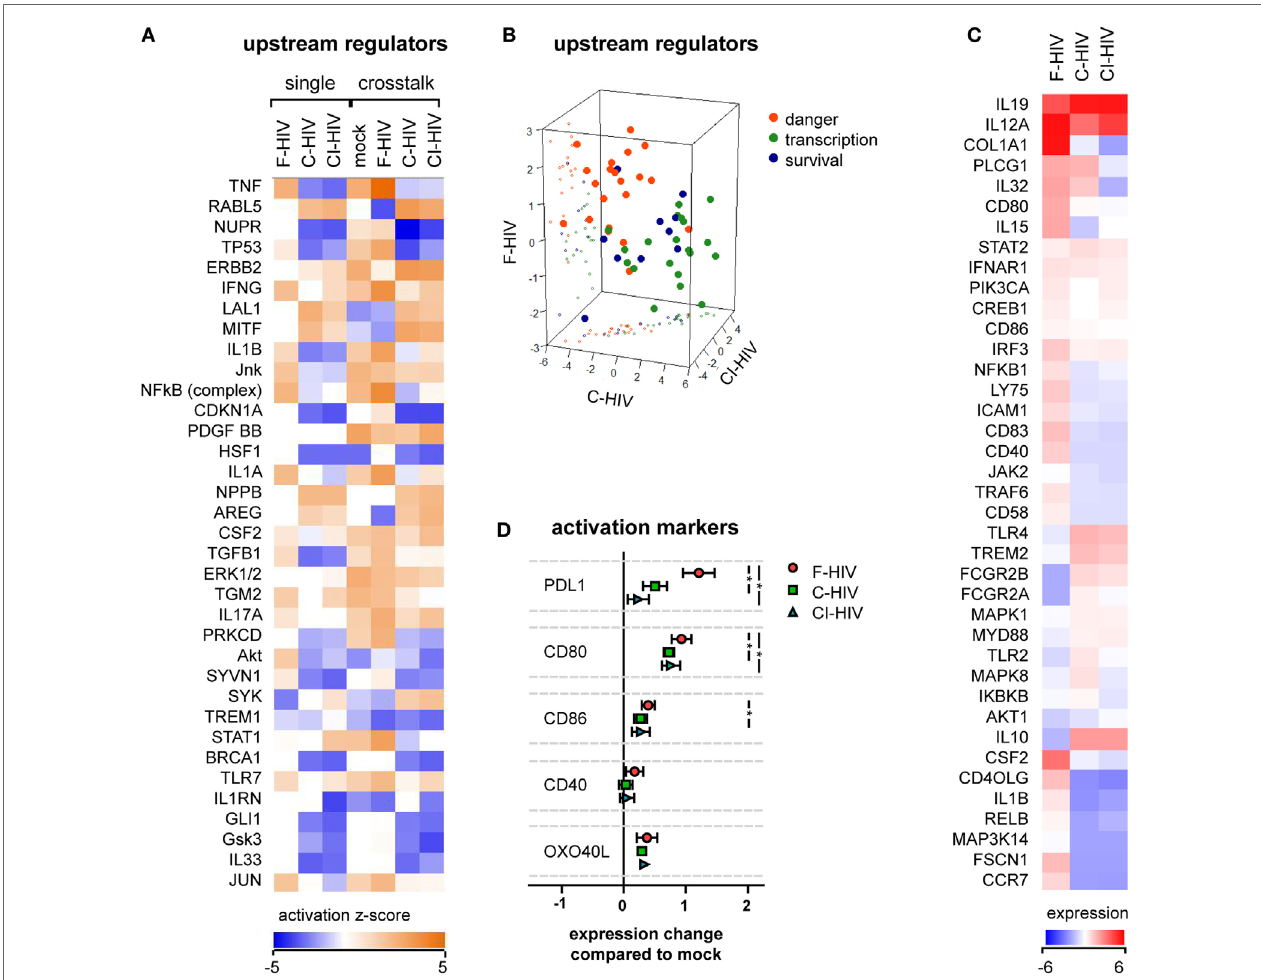
FigUre 2 | HIV effects on dendritic cell (DC) activation in the absence or presence of natural killer (NK) cells. DCs were exposed to 1 μ g/ml F-HIV, complement- opsonized HIV complement- and antibody opsonized HIV (CI-HIV), CI-HIV, or mock treated either in DC single culture, or in a cross talk culture consisting of NK cells and DCs from the same donor at a 1:1 ratio for 24 h. The experiment was replicated three times using cells derived from three different donors. (a) RNAseq was performed on the DCs from the single culture or DCs isolated from the NK–DC cross talk, and the genes that were significantly differentially expressed were analyzed using IPA (Qiagen) to determine the most affected upstream regulators. (B) The top upstream regulators were divided into functional groups, and a 3D scatterplot was used to visualize clustering. (c) A heatmap was generated for genes that were significantly differentially expressed in at least one condition and that were defined by IPA to be involved in DC maturation. The heatmap shows fold change in the virus exposed cross talk samples compared to the mock treated cross talk samples. (D) The protein expression of surface activation markers on the DCs from the cross talk cultures was assessed using flow cytometry, and the values normalized to the expression in the mock-treated cross talk culture. One-way ANOVA followed by a Bonferroni posttest was used to test for statistically significant differences in protein expression. Boxplots show mean ± SEM (* p <